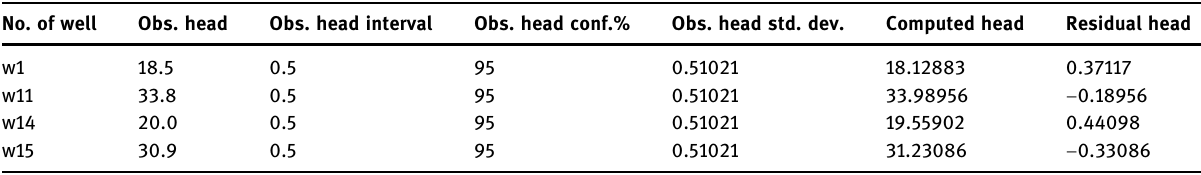
Table 3: Values of the observed and computed piezometric head No. of well Obs. head Obs. head interval Obs. head conf.%